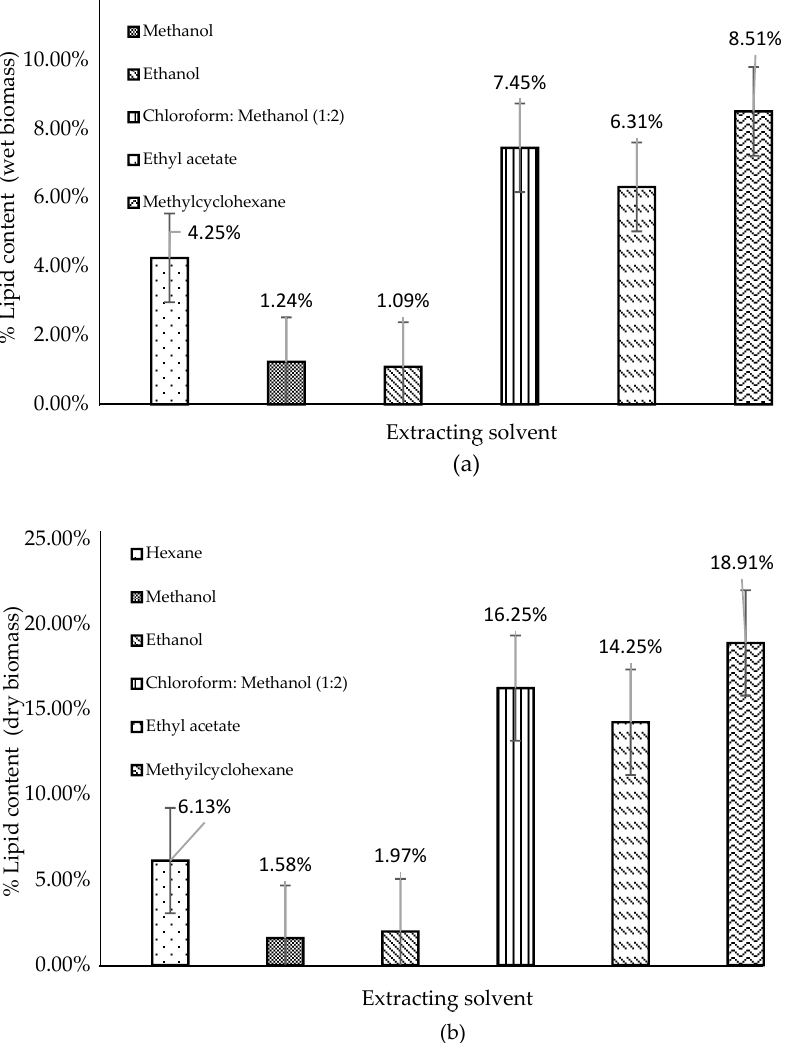
Figure 3. Lipid content of Scenedesmus sp. growth in pig slaughterhouse wastewater for 11 days in ( a ) wet biomass and ( b ) dry biomass. The values are presented as means of triplicate measures with their corresponding standard deviation (±SD).